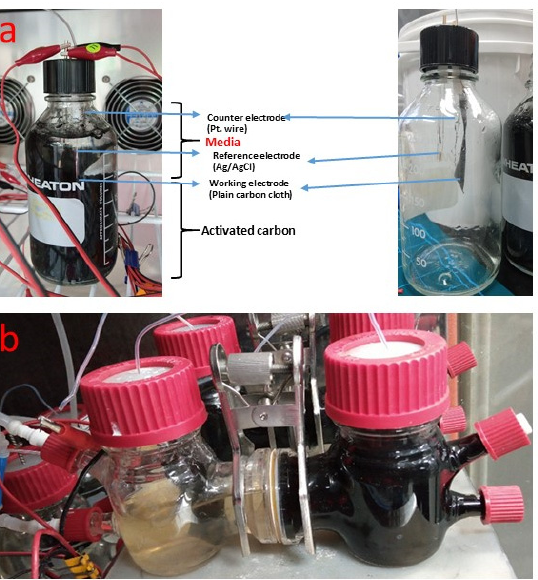
Figure 1. Enrichment of denitrifying bacteria on GAC by applying different strategies. ( a ) Bottle enrichment with a three-electrode system incubated at 30 °C and ( b ) the MFC with NO 3 − -N (100 mg/L NO 3 − -N)-composed media in a cathode operated at 30 °C.